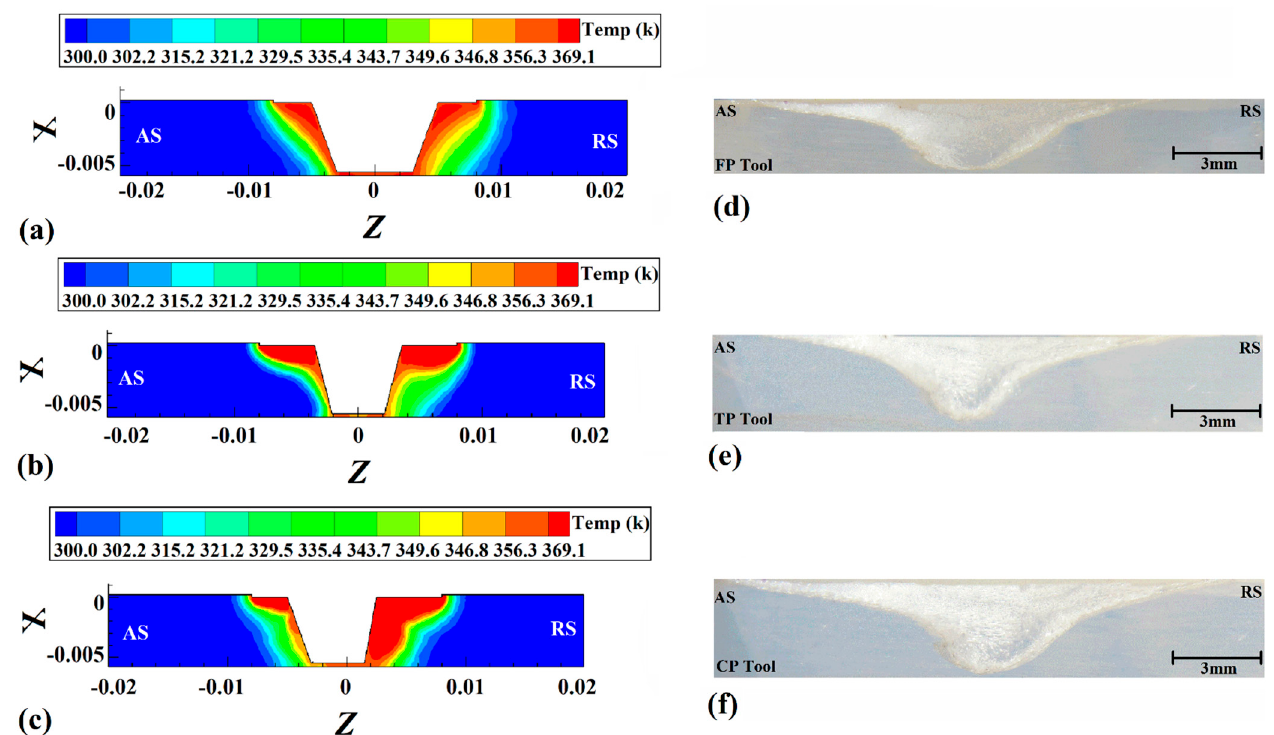
Figure 6. Simulation results in a cross-section view of internal heat flux with ( a ) FPT, ( b ) TPT and ( c ) CPT pins. Cross-section view of FSWed samples with ( d ) CPT, ( e ) CPT and ( f ) FPT pins.